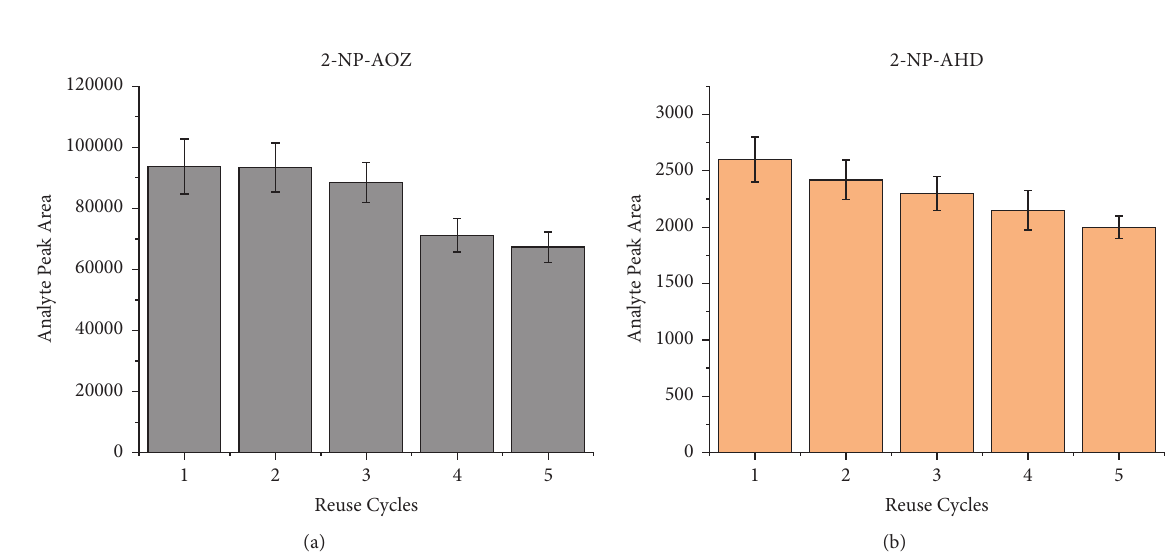
Figure 4: Effect of extraction time on the SPME efficiency.